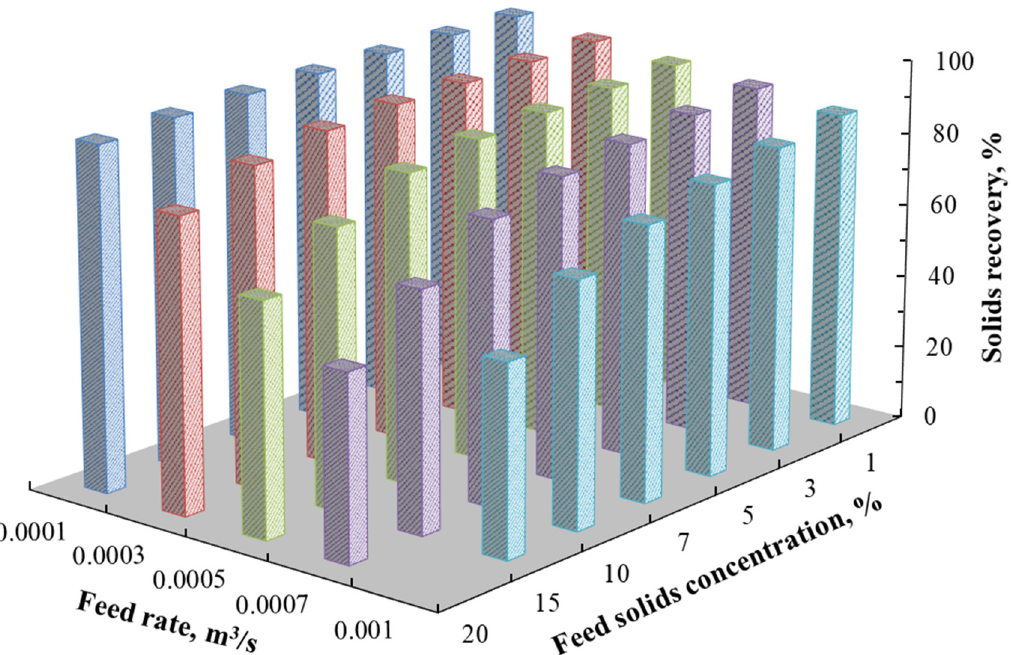
Figure 10. The relationship between the feed rate & feed solids concentration and solids recovery.